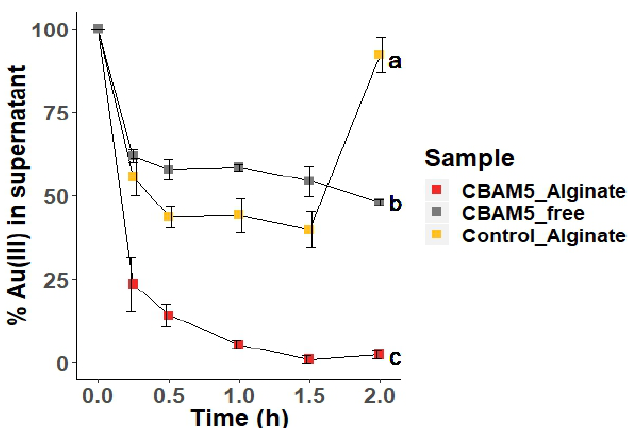
Figure 2. Gold (60 ppm) biosorption assays with free (CBAM5_free) and encapsulated (CBAM5_Alginate) cells of L. sphaericus CBAM5 with pH = 5–6. Control_Alginate: assay with alginate spheres without bacteria. Points at 2 h denoted by a different letter differ significantly at P < 0.05 according to a one-way ANOVA and a Tukey analysis.